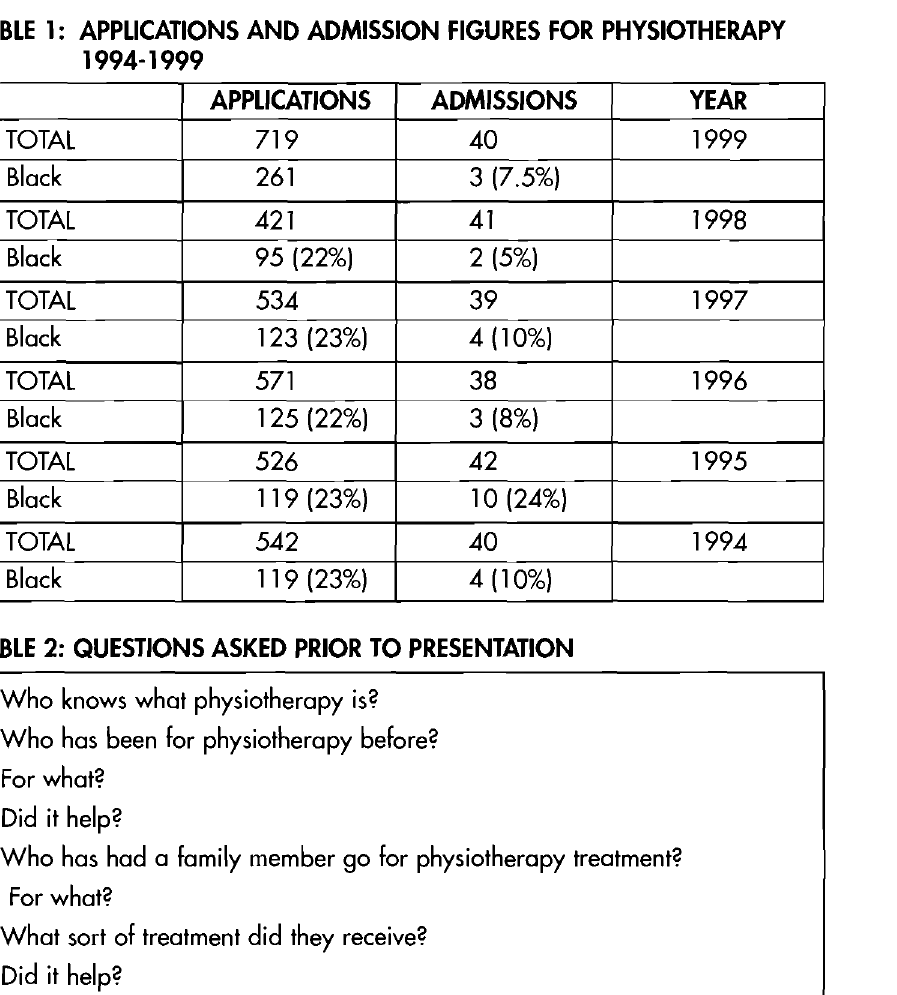
TABLE 1: APPLICATIONS AND ADMISSION FIGURES FOR PHYSIOTHERAPY